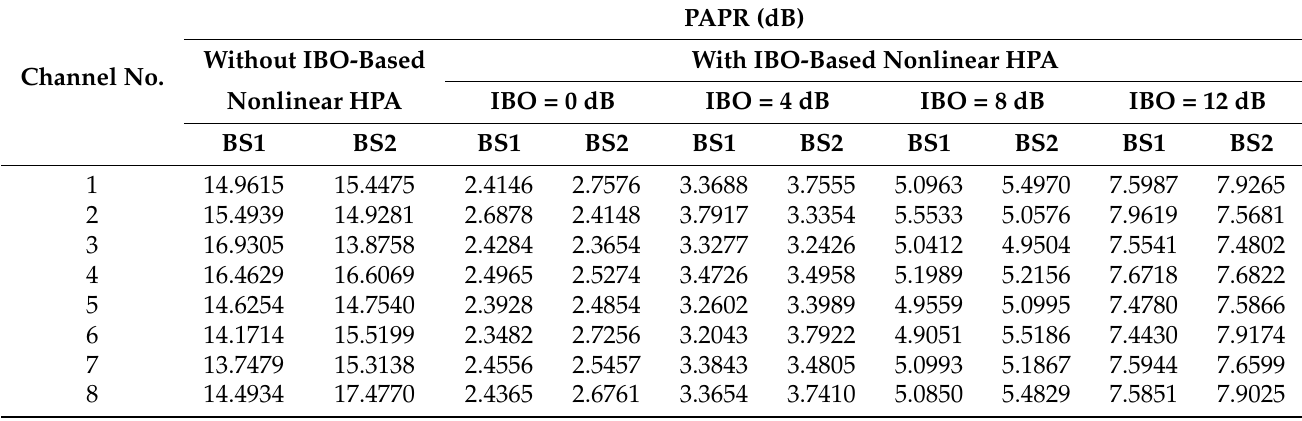
Table 4. Estimated PAPR at different channels of